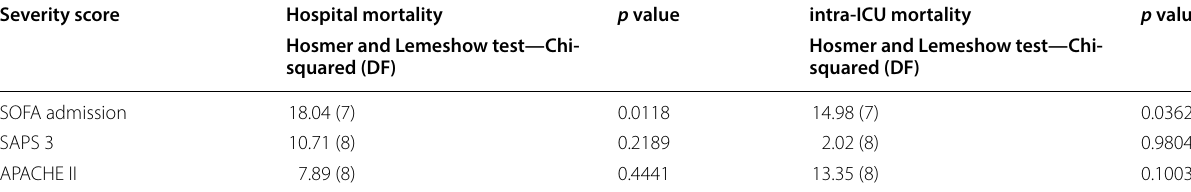
Table 5 Prognostic model’s calibration values for hospital and intra-ICU mortalities as outcomes